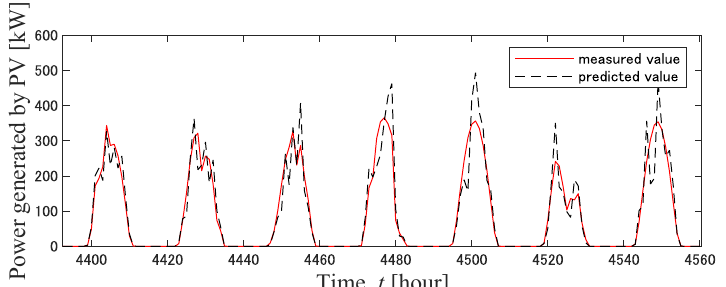
Figure 9. Power generated by PVs